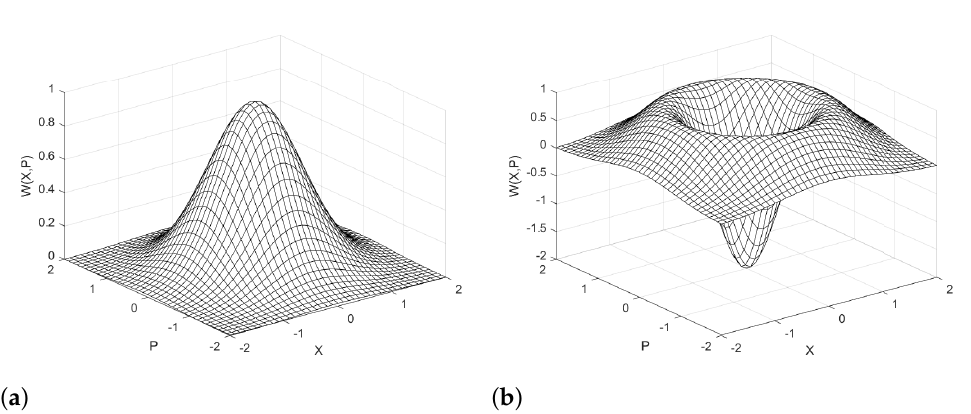
Figure 1. Wigner functions for the ( a ) ground state, W 0 ( x , p ) = 2exp ( − p 2 − x 2 ) , and ( b ) excited state, W 1 ( x , p ) = 2 ( − 1 + 2 p 2 + 2 x 2 ) exp ( − p 2 − x 2 ) , of the quantum harmonic oscillator whose dimensionless Hamiltonian is ˆ H = − 1 from Ref.